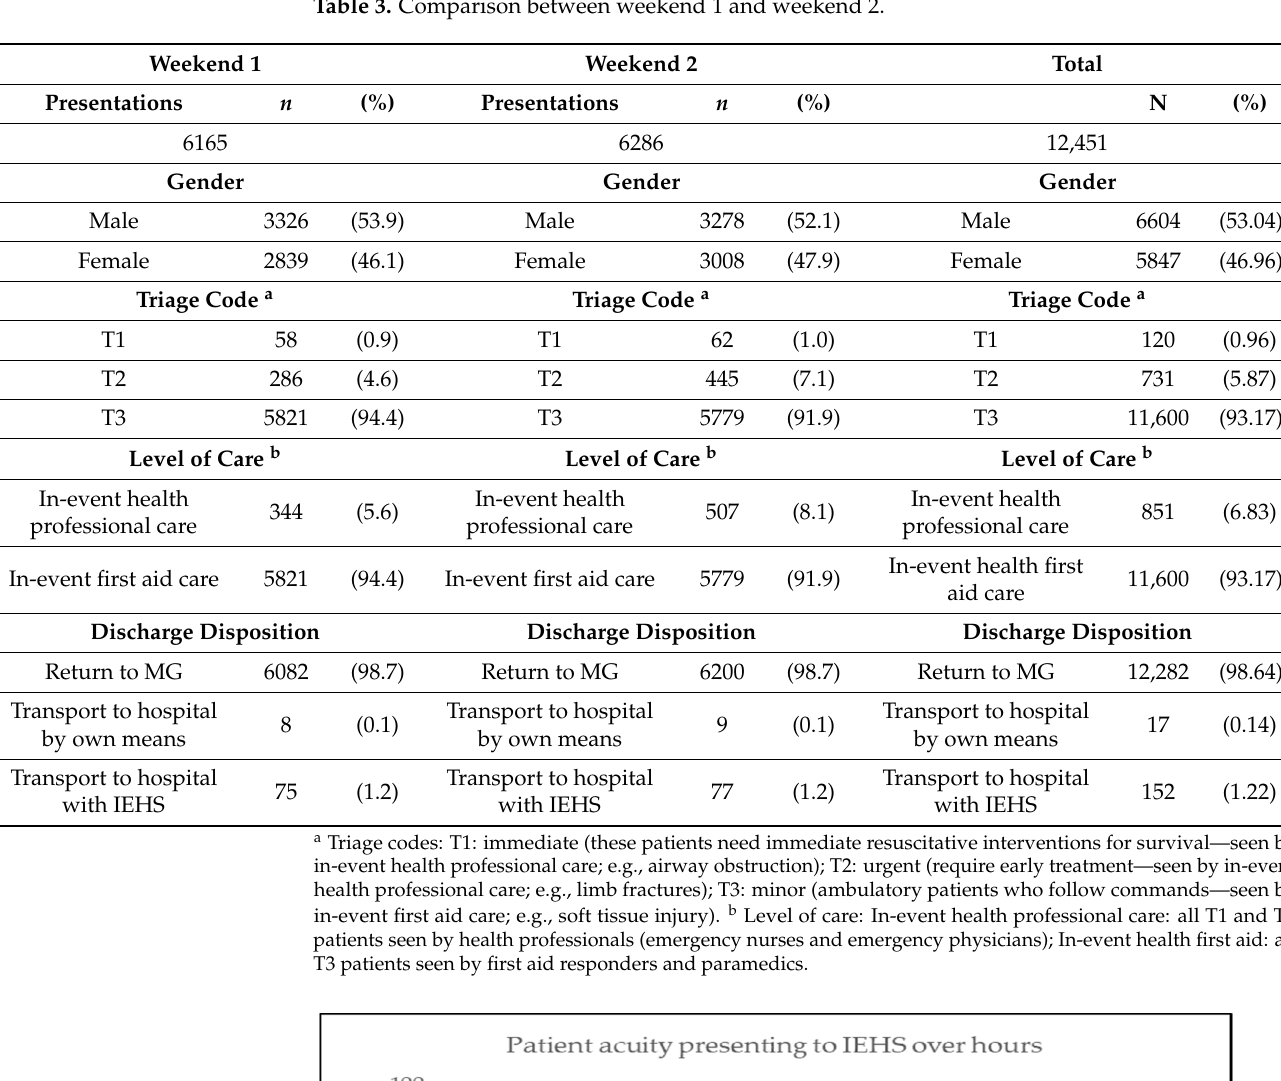
Table 3. Comparison between weekend 1 and weekend 2.